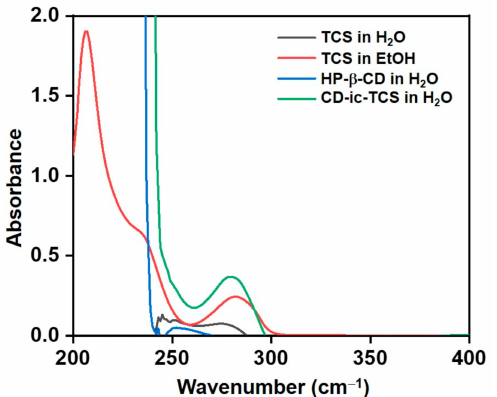
Figure 3. UV spectra of TCS in H 2 O, TCS in EtOH, HP- β -CD in H 2 O, and CD-ic-TCS in H 2 O. The spectra were monitored from 200 to 400 cm − 1 . TCS—triclosan; HP- β -CD—2-hydroxypropyl-beta- cyclodextrin; CD-ic-TCS—inclusion complex between HP- β -CD and TCS.